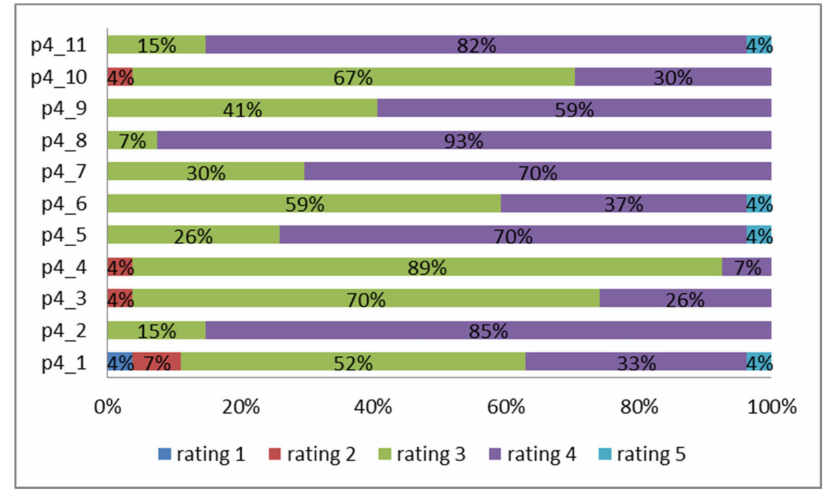
Figure 5. Assessment of the CE requirements in relation to the management of a coal power